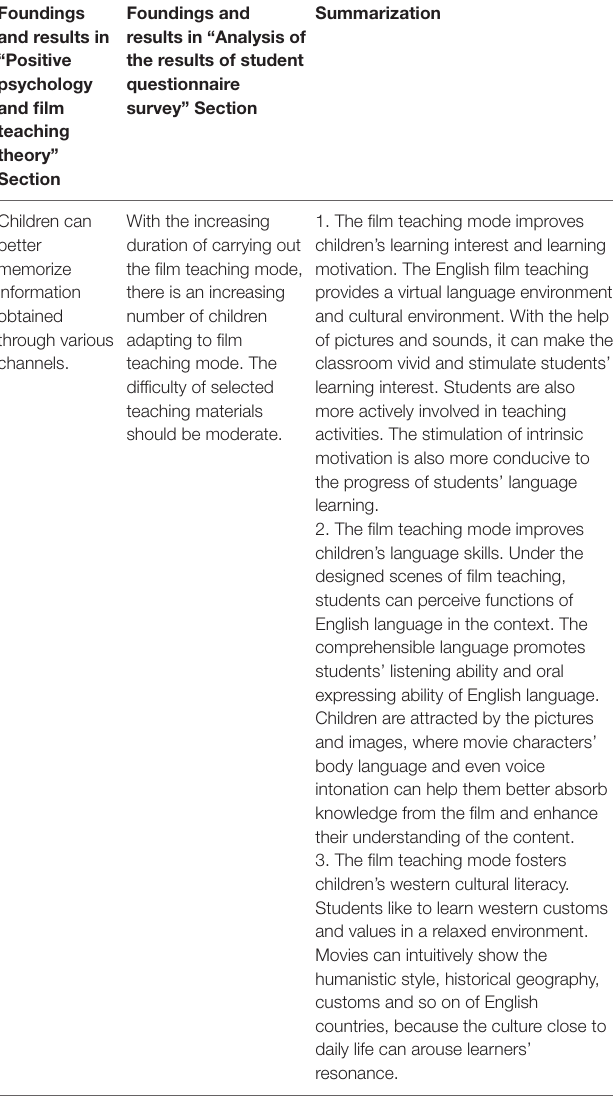
TABLE 6 | Summarization of the research achievements and